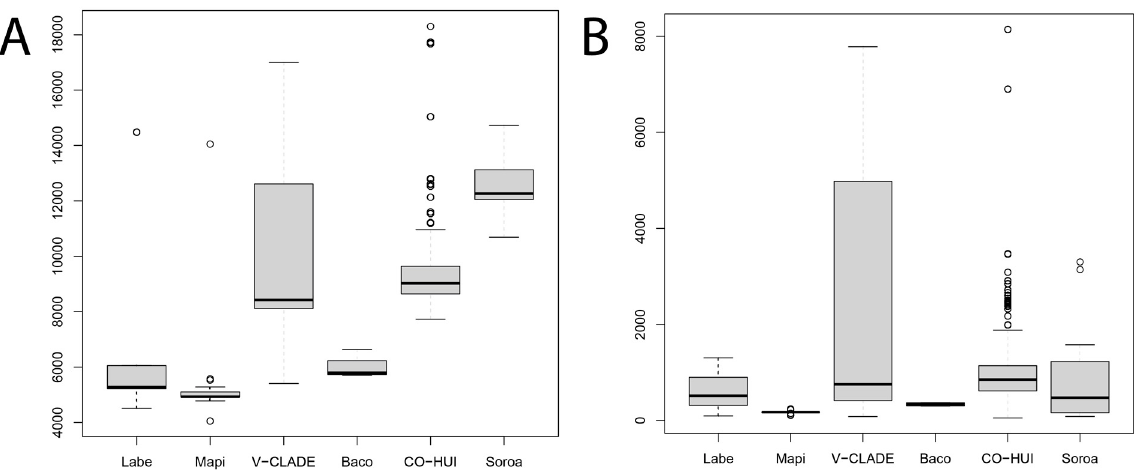
Figure 3. Length distribution of 54,125 full copies of the LTR-RTs detected following the 80-80-80 rule in the Hv33 assembly. ( A ) A full-length element sequence. ( B ) An LTR domain.